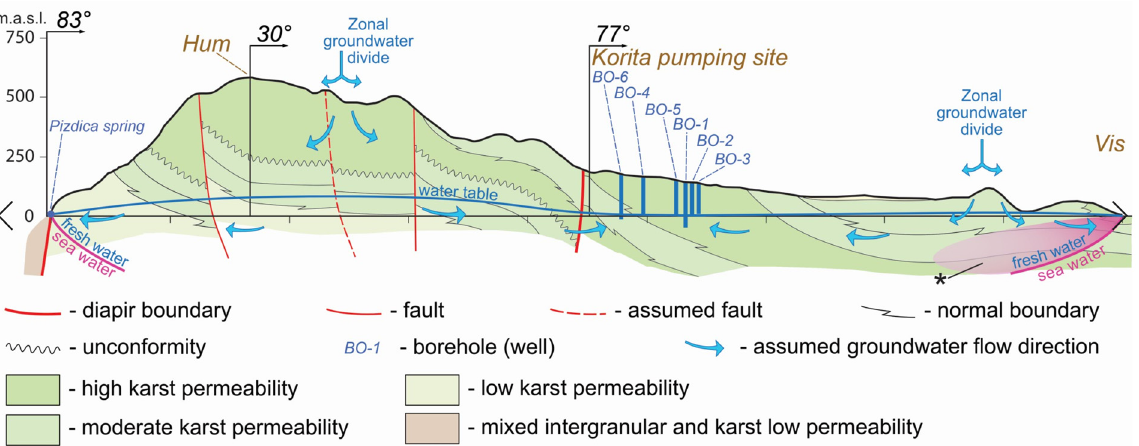
Figure 10. Schematic hydrogeological cross-section from the Pizdica spring, over the island’s highest peak, and through the region of the Korita wells (BO-6 to BO-2) towards Vis town in the east. The legend and position of the cross-section are shown in Figure 4. * Indicates the most probable direction of the seawater wedge towards the Korita wells if the freshwater level drops in the future (either because of increased pumping rates or lower recharge due to climate change influences).